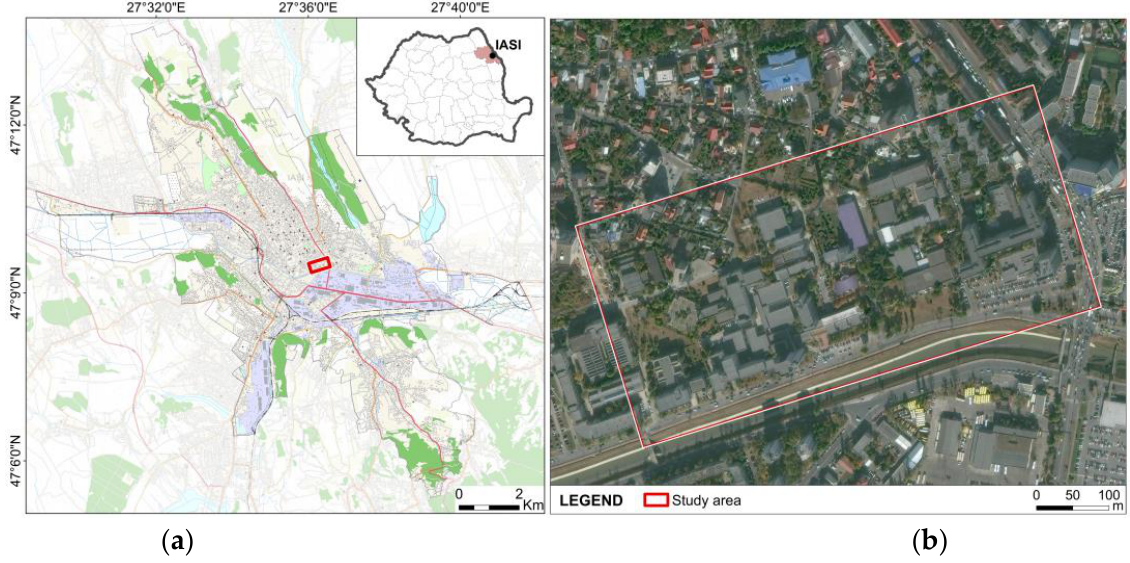
Figure 1. Location of the study area: ( a ) Regional context; ( b ) “Gheorghe Asachi” Technical University of Iasi, Romania.